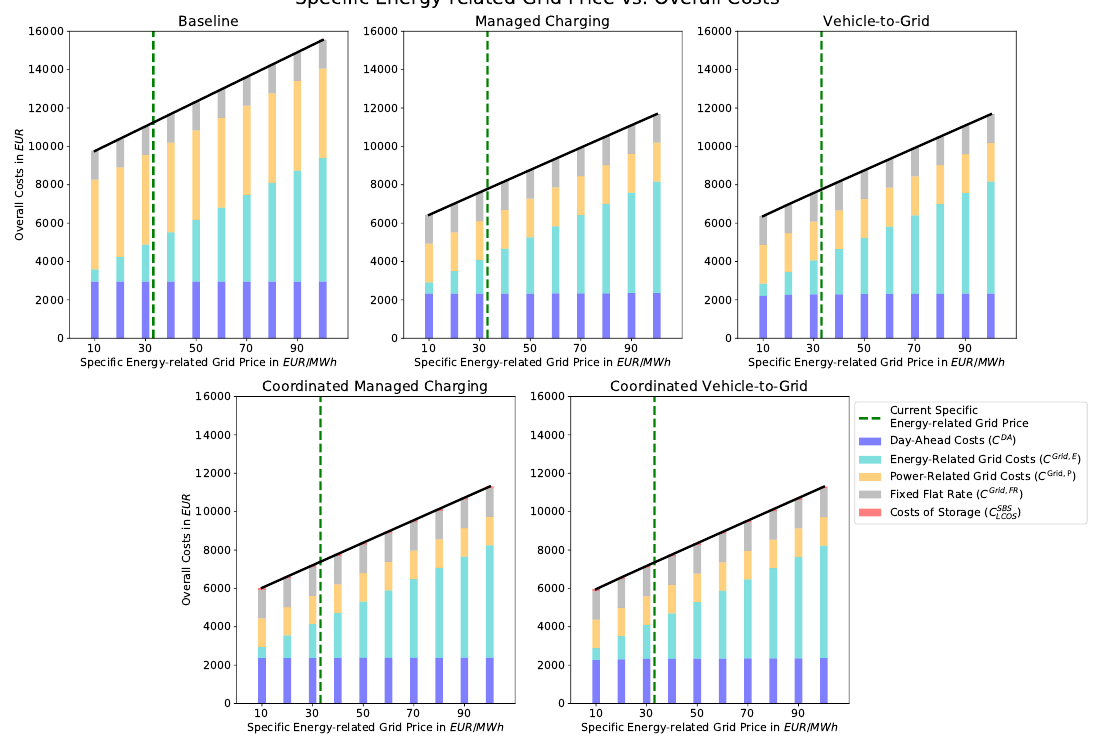
Figure 7. Specific energy-related grid price vs. overall